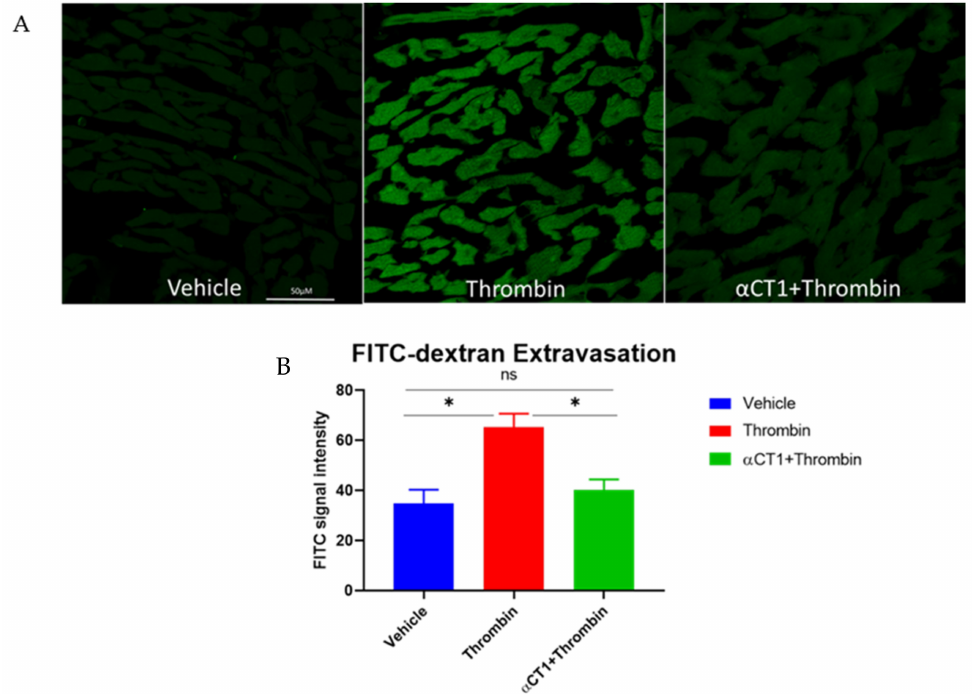
Figure 10. α CT1 inhibits thrombin-intravascular leak in Langendorff-perfused mouse hearts. ( A ) Representative confocal images of FITC-dextran extravasation within Langendorff-perfused mouse hearts. ( B ) Quantification of FITC-dextran signal within mouse hearts perfused 40 min with thrombin (1.5 U/mL) with or without 20 min α CT1 (100 µ M) pretreatment. SE bars, * p <